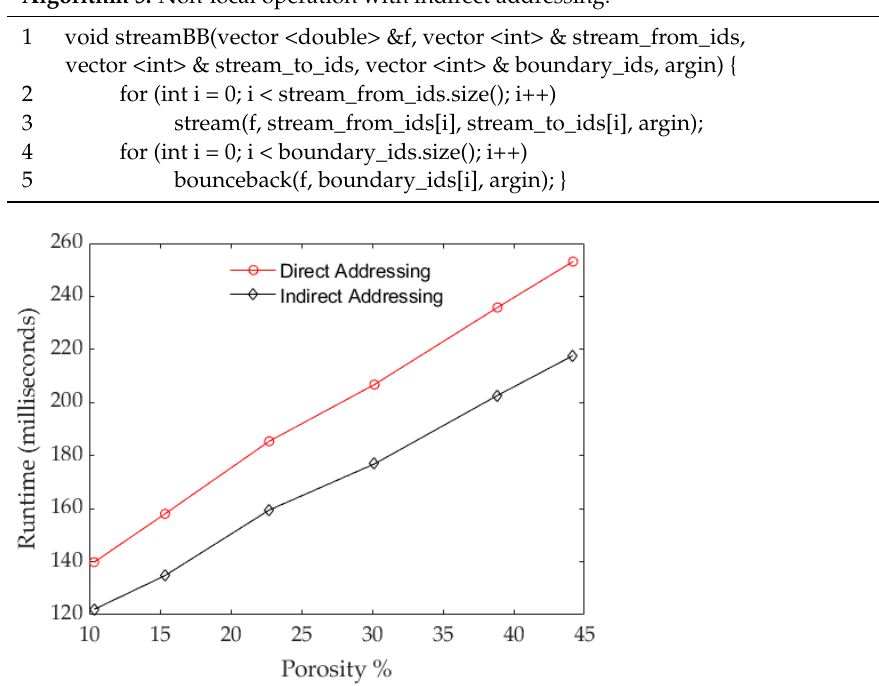
Algorithm 5. Non-local operation with indirect addressing.